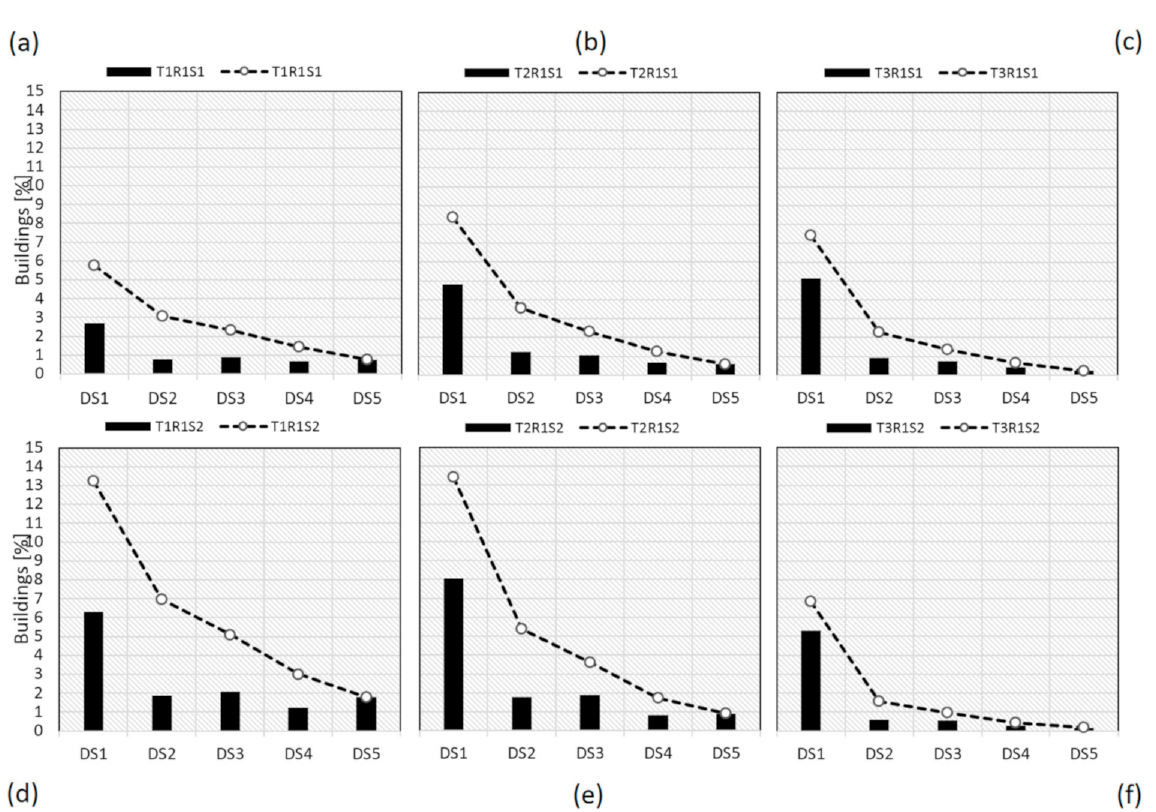
Figure 5. Relative frequency distribution of census-based typological classes for each damage state